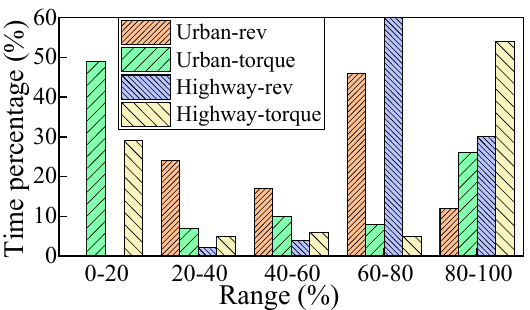
Figure 19. Time percentage of each speed and torque of vehicles under urban and expressway conditions.